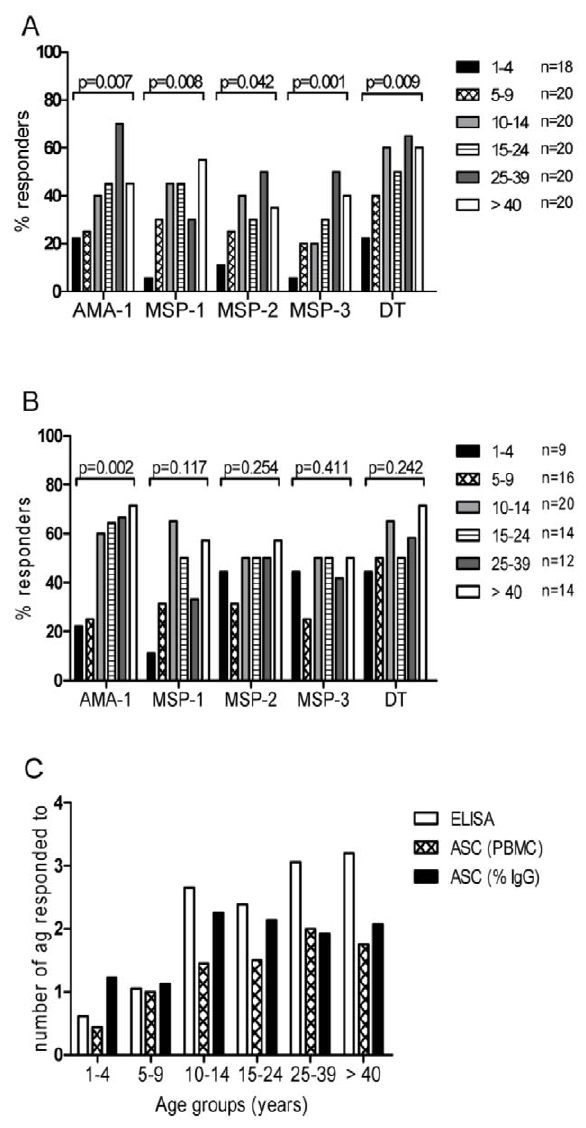
Figure 3. Prevalence and antigenic breadth of the malaria- specific MBC response increases with age. The percentage of individuals in each age group with detectable MBC specific for the different malaria Ags and for DT are shown as (A) number of MBC/ PBMC, and as (B) % of all MBC. P-values for a Chi-squared test for trend are shown. N equals the number of samples tested per age group. The average number of Ags for which individuals had specific Ab (open bars) or MBC (hatched bars=MBC/PBMC; black bars=%ASC) are shown, by age group, in (C). For all three parameters, the Chi-squared test for trends indicated a significant increase with age (p , 0.0001 for Ab and MBC/PBMC, and p=0.0083 for %MBC). Positive responses to individual antigens were defined as described in